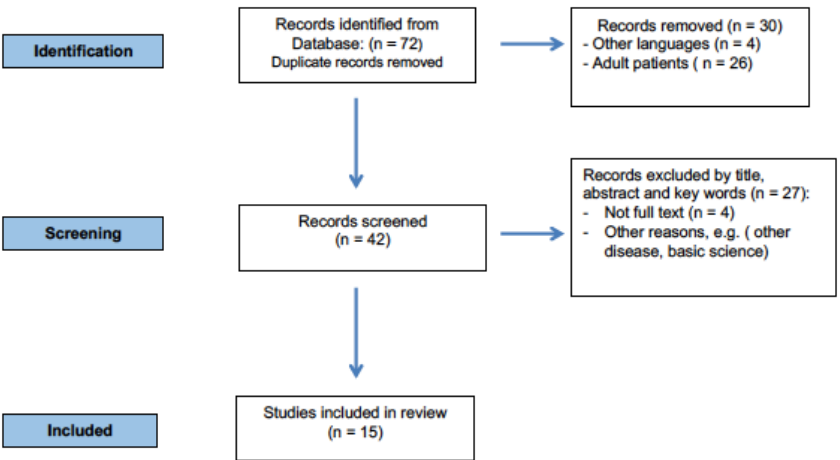
Figure 1. Flowchart of the literature search and study selection process.